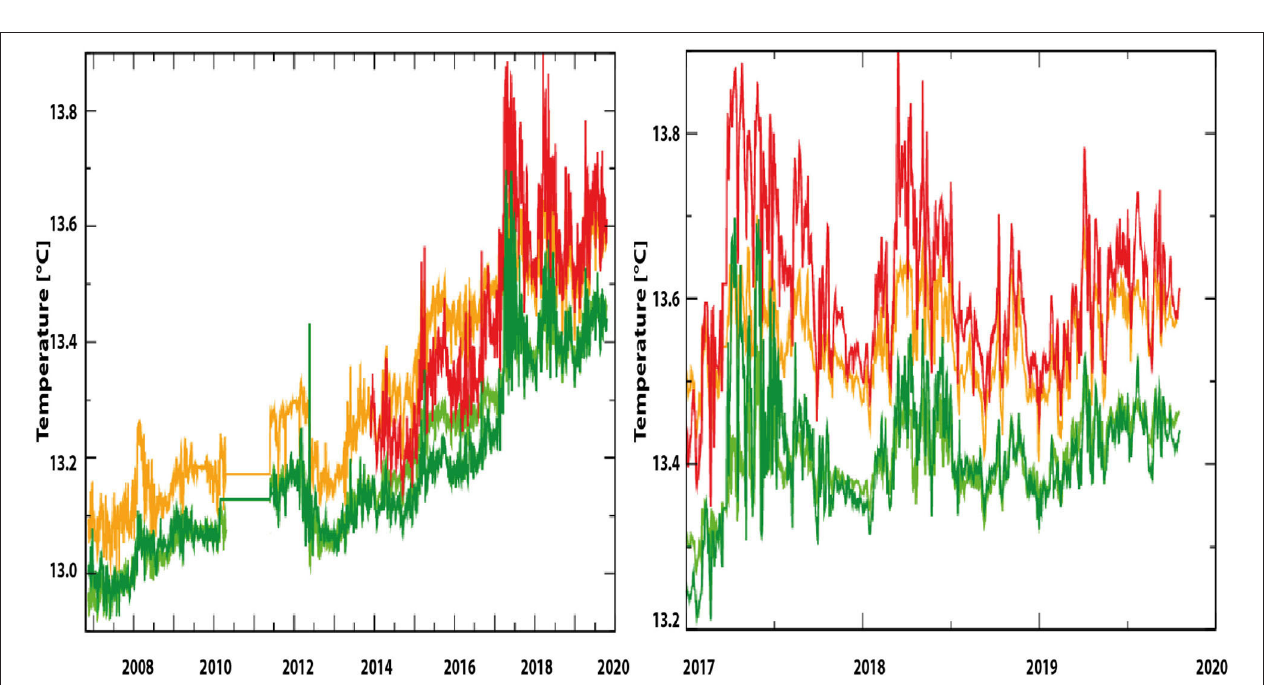
FIGURE 5 | Observed data at 900 m (red) and 1,000 m (light green) and their interpolations 900 m (orange) and 1,000 m (dark green). The right figure is a magnification of the data starting in 2017.